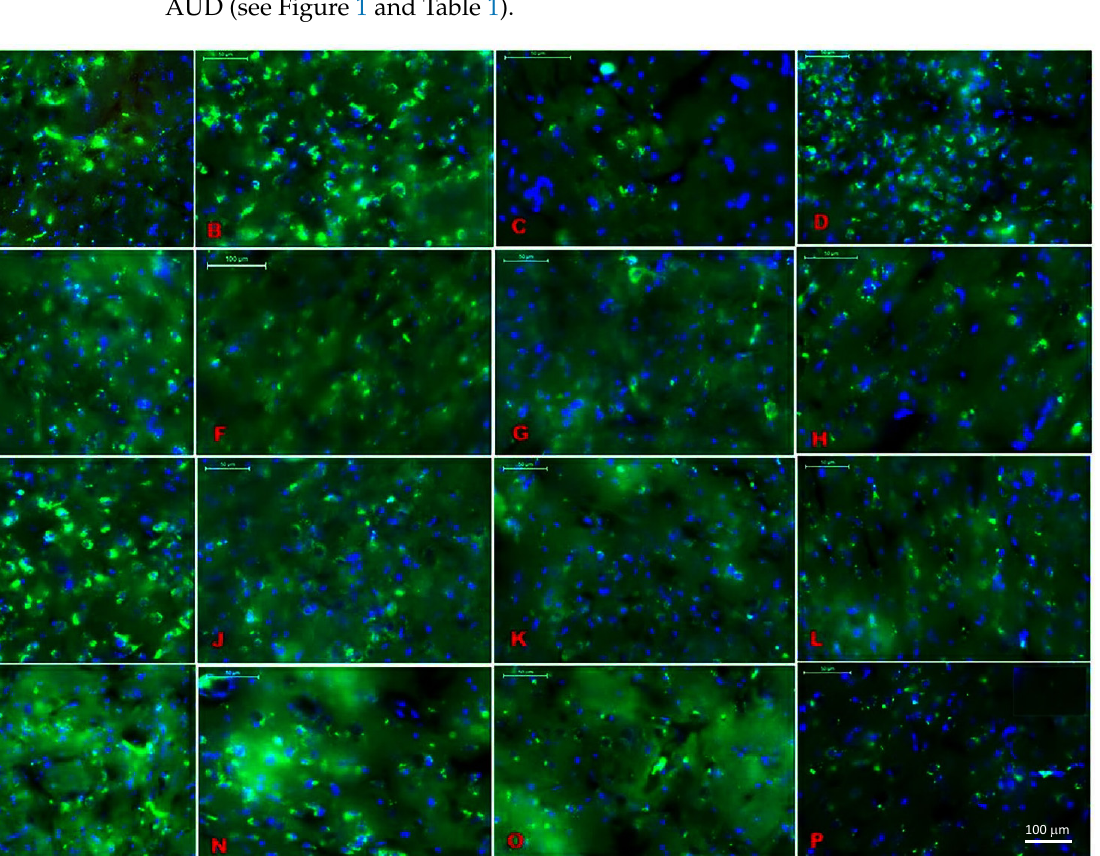
Figure 1. MT1 receptor distribution using FITC (florescent green) and DAPI (blue) staining in the specific brain regions. ( A ) Ventral posteromedial thalamic nucleus (VPM), ( B ) Somatosensory cortex (S1), ( C ) Dentate gyrus (DG), ( D ) Amygdalostriatal transition area (Astr), ( E ) Secondary auditory cortex (AUD), ( F ) Basolateral amygdala (Bla), ( G ) Lateral hypothalamus (LH), ( H ) Magnocellular region (Mc), ( I ) Magnocellular nucleus of lateral hypothalamus (Mclh), ( J ) Nigrostriatal fibers (Ns), ( K ) Posterior hypothalamic area (Ph), ( L ) Retrosplenial agranular cortex (Rsa), ( M ) Posterior thalamic nuclear group (Po), ( N ) Ventromedial thalamic nucleus (VM), ( O ) Ventromedial hypothalamic nucleus (VMH), and ( P ) Reticular thalamic nucleus (RT). Scale bar is 100 µ